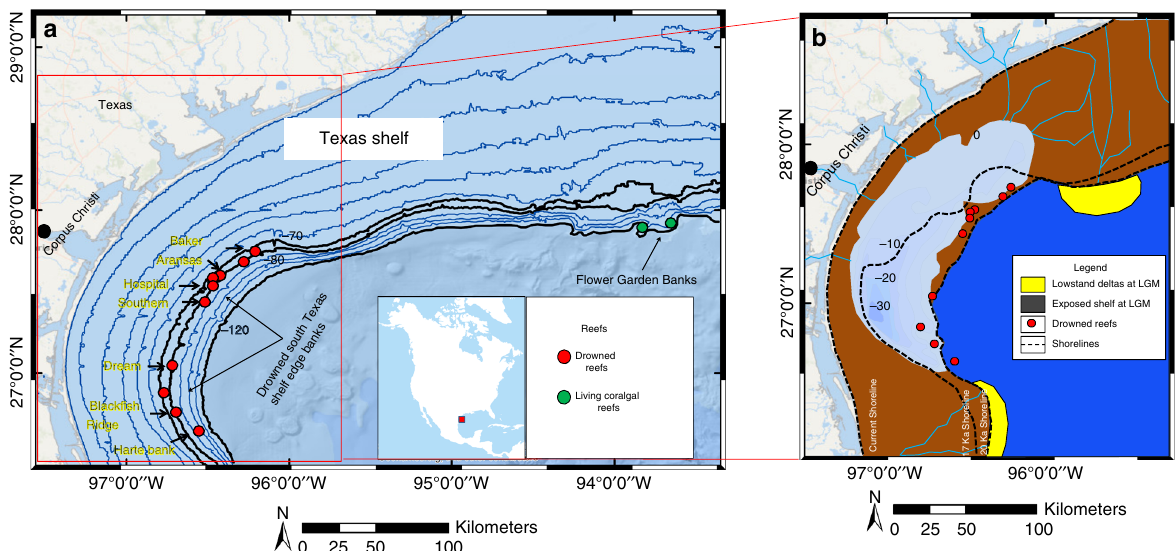
Fig. 1 Modern and uppermost Pleistocene Texas shelf where living and drowned coralgal reefs are located. a Drowned banks along the south Texas shelf edge are shown as red dots. The Flower Garden Banks, living coralgal reefs 150 km south of Galveston Island, are displayed as green dots. Note that, with one exception, the drowned reefs are currently located between 70 and 80 m isobaths. b Uppermost Pleistocene south Texas shelf coastal systems at 20 and 17 ka 20 (located in Fig. 1a by red rectangle), illustrate a shallow bay up to 35 m deep, isolated from the open ocean by a barrier island complex, on top of which the south Texas reefs (shown in red dots) were established during the early part of last